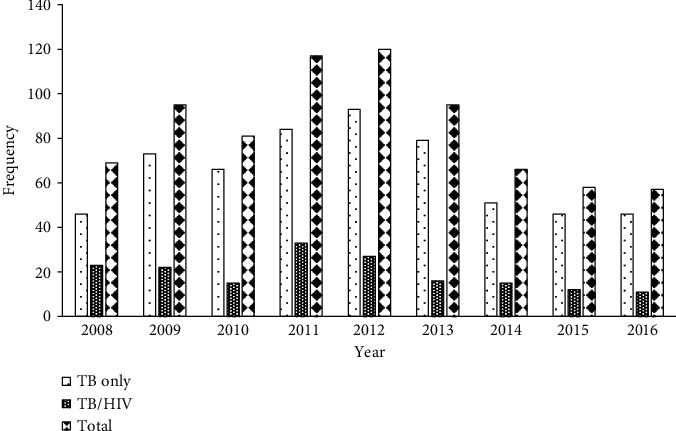
TB cases by HIV status registered in the Greater Accra Regional Hospital, 2008-2016.